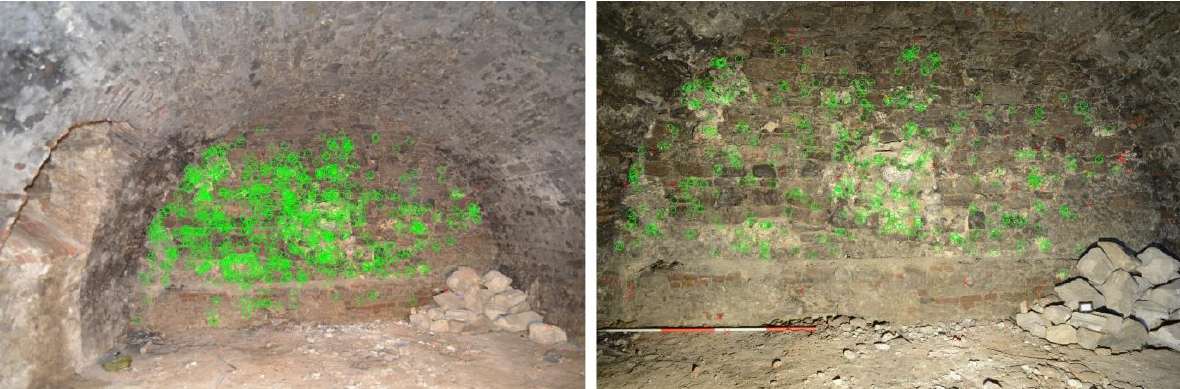
Fig. 11 Utilised photographs with points used for orientation (in green) and points deleted from the process of adjustment (in red)